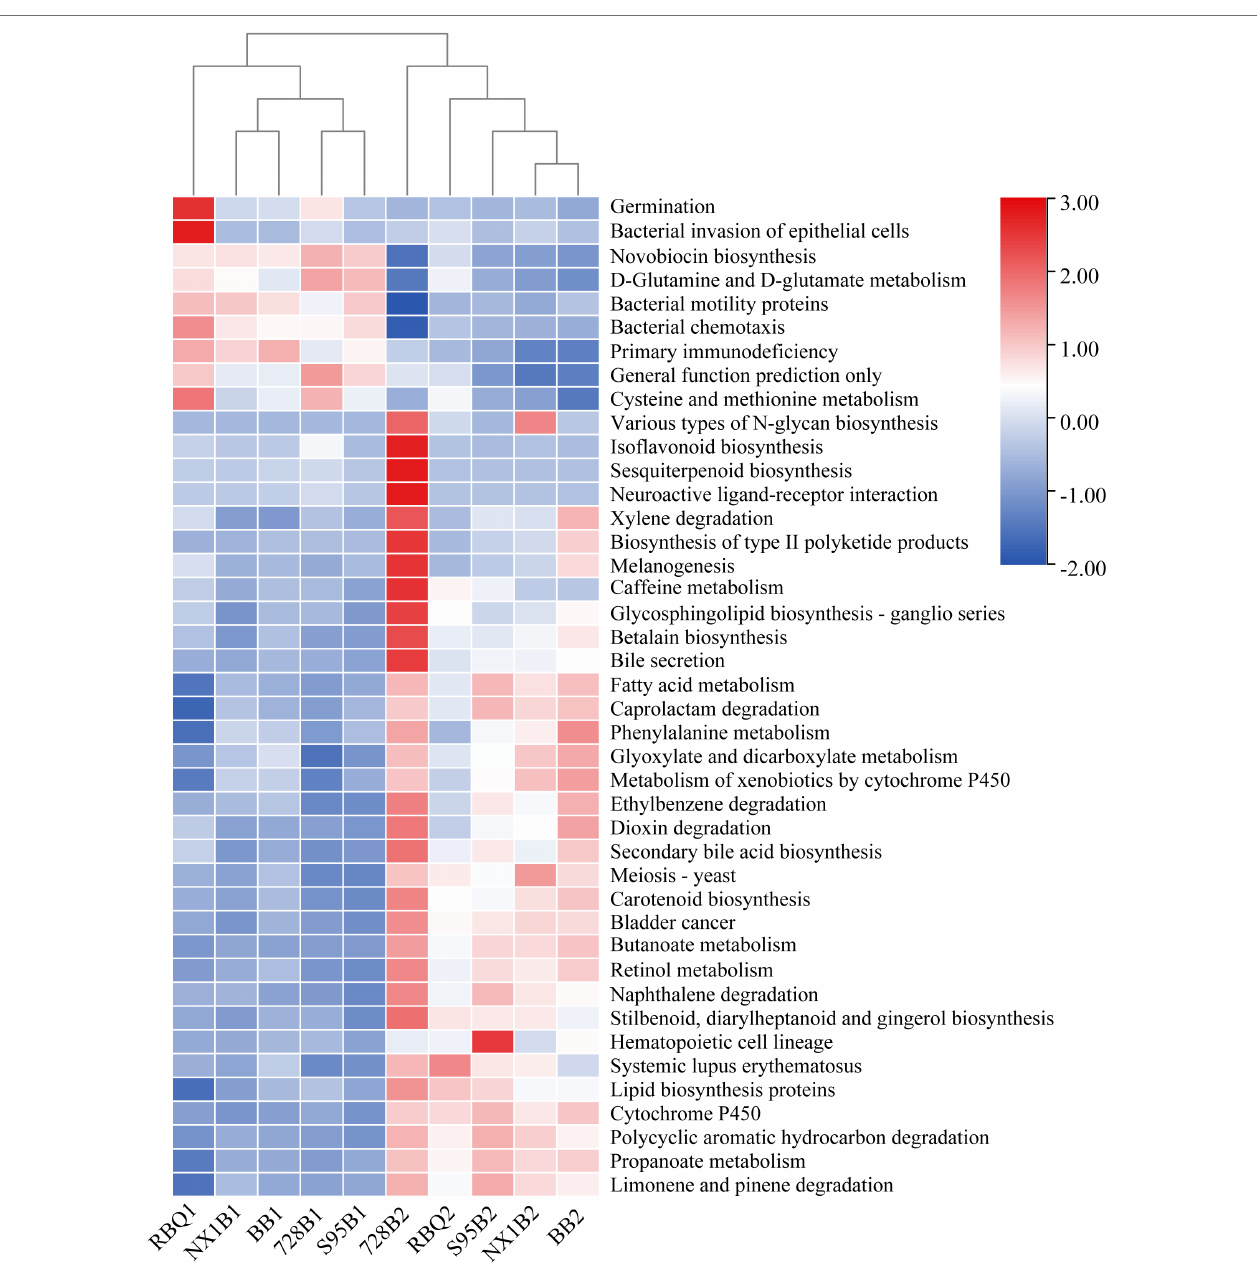
FIGURE 6 | Predicted gene functional categories of the endophytic microbiome of five rice cultivars at the vegetative and reproductive stages. The heat map is drawn for a total of 42 metabolic pathways which were significantly changed from the vegetative to reproductive